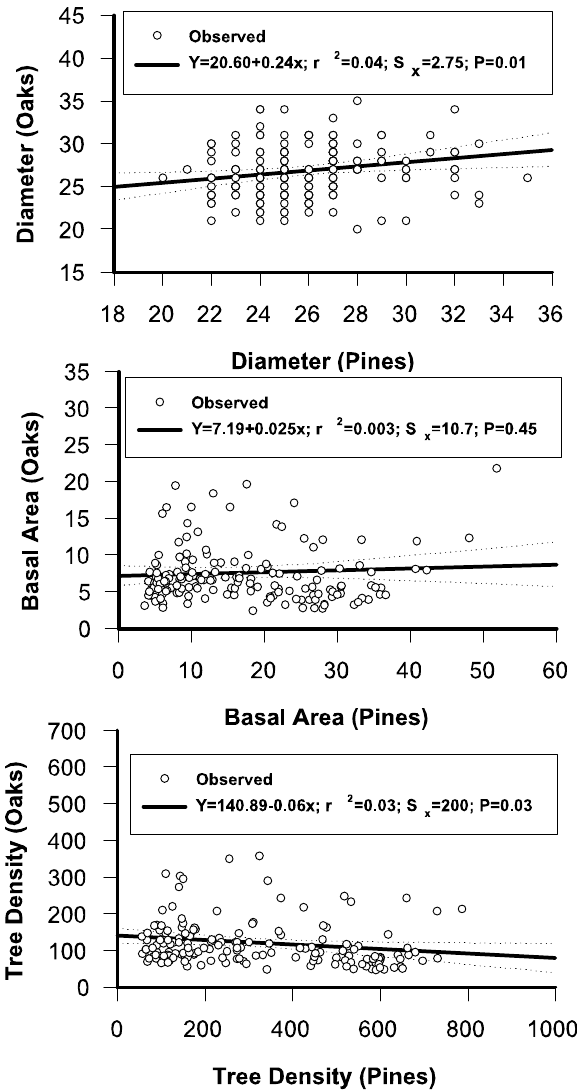
( r 2 = coefficient of determination, Sx = Standard error, P =